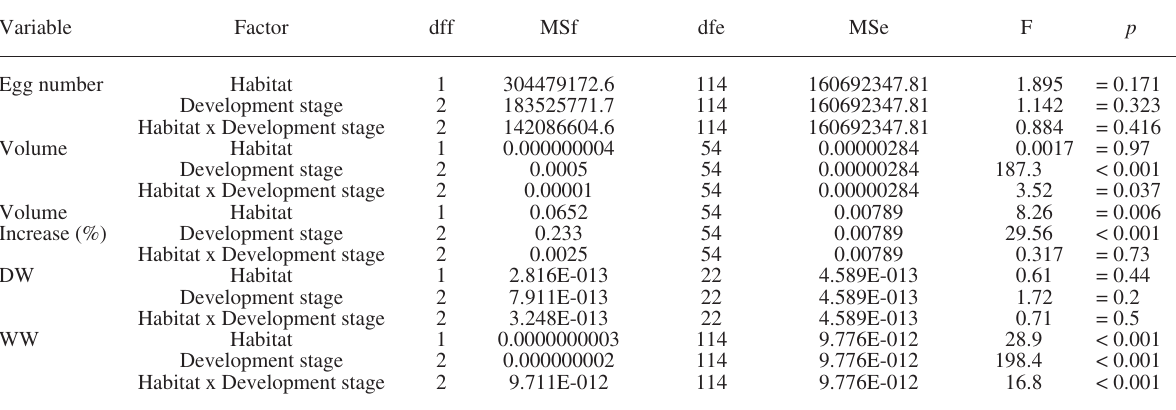
Table 4. – Neohelice granulata . Two-way anoVa evaluating differences in egg number, egg volume, percentage increments in egg volume, dry weight (dW), wet weight (WW) comparing different stages of embryonic development (i, ii, iii) and habitats (mudflats vs saltmarshes);